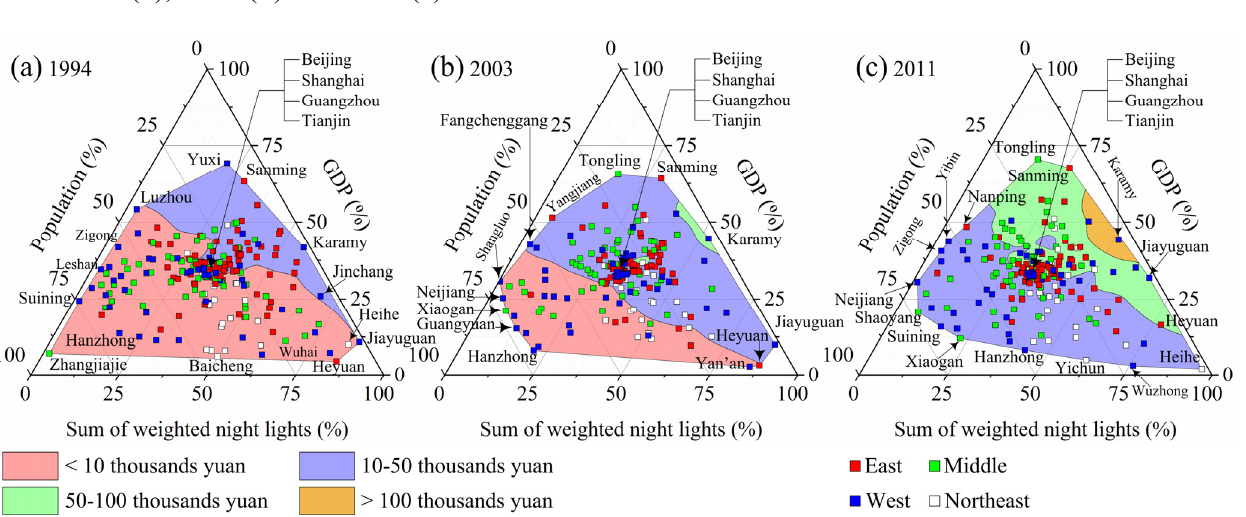
Figure 7. Ternary plots with contours of GDP per capita of China’s cities in 1994 ( a ), 2003 ( b ) and 2011 ( c